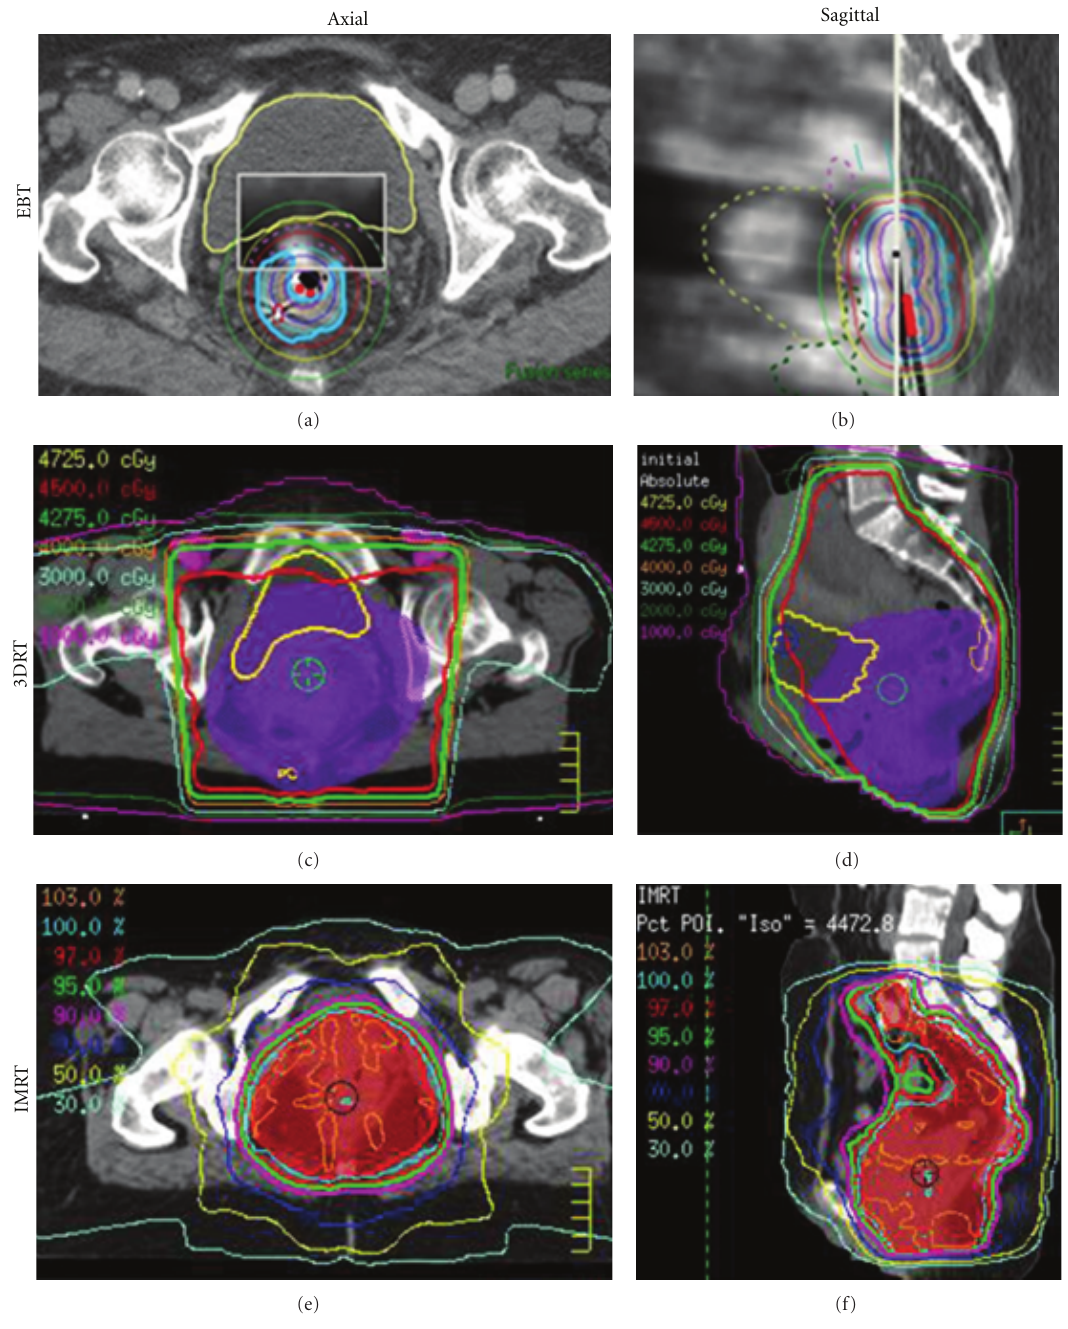
Figure 1: Representative slices from each of the three radiation plan types taken from a similar level in the pelvis. EBT can be seen to achieve a high dose to the tumor while exposing markedly less normal tissue volume to ionizing radiation as a result of rapid dose fall o ff from the point source. Top row: in axial (a) and sagittal (b), slices from an EBT plan, the 100% (light blue), 95% (red), 50% (yellow), and 30% (green) isodose lines are shown and the tumor perimeter is contoured (thick light blue line) as well as the bladder perimeter (thick yellow line in axial image, dotted yellow line in sagittal image). Middle row: in axial (c) and sagittal (d) slices from a 3DRT plan, the 100% (red), 95% (bright green), 89% (orange), 67% (gray), 44% (dark green), and 22% (fuchsia) isodose lines are shown, and the planning target volume receiving the full radiation dose around the tumor is indicated (purple shading) as well as the bladder perimeter (yellow). Bottom row: in axial (e) and sagittal (f) slices from an IMRT plan, the 100% (light blue), 97% (red), 95% (green), 90% (fuchsia), 70% (royal blue), 50% (yellow), and 30% (gray) isodose lines are shown, and the planning target volume receiving the full radiation dose around the tumor is indicated (red